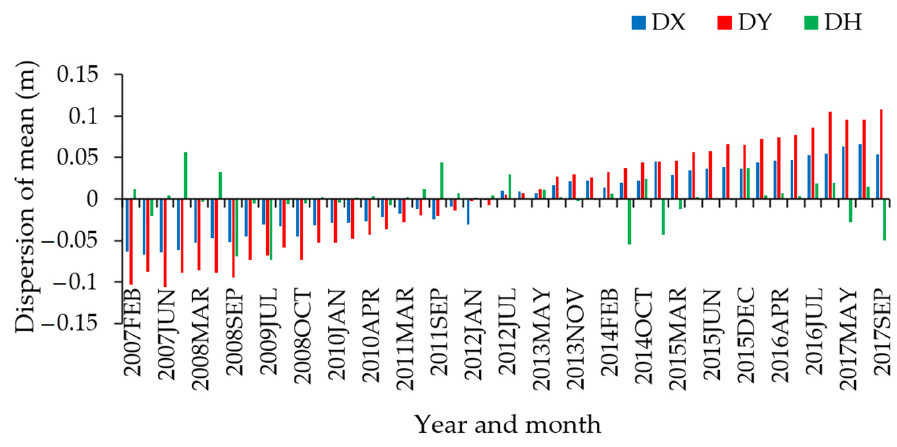
Figure 3. Differences of station RIGA monthly mean coordinate components.